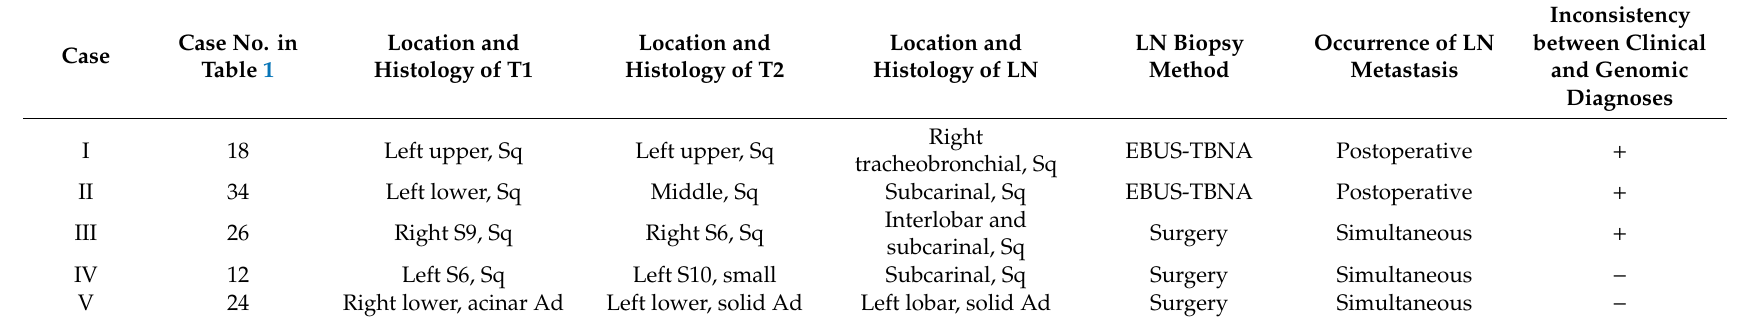
Table 2. LN metastasis in patients with multiple lung